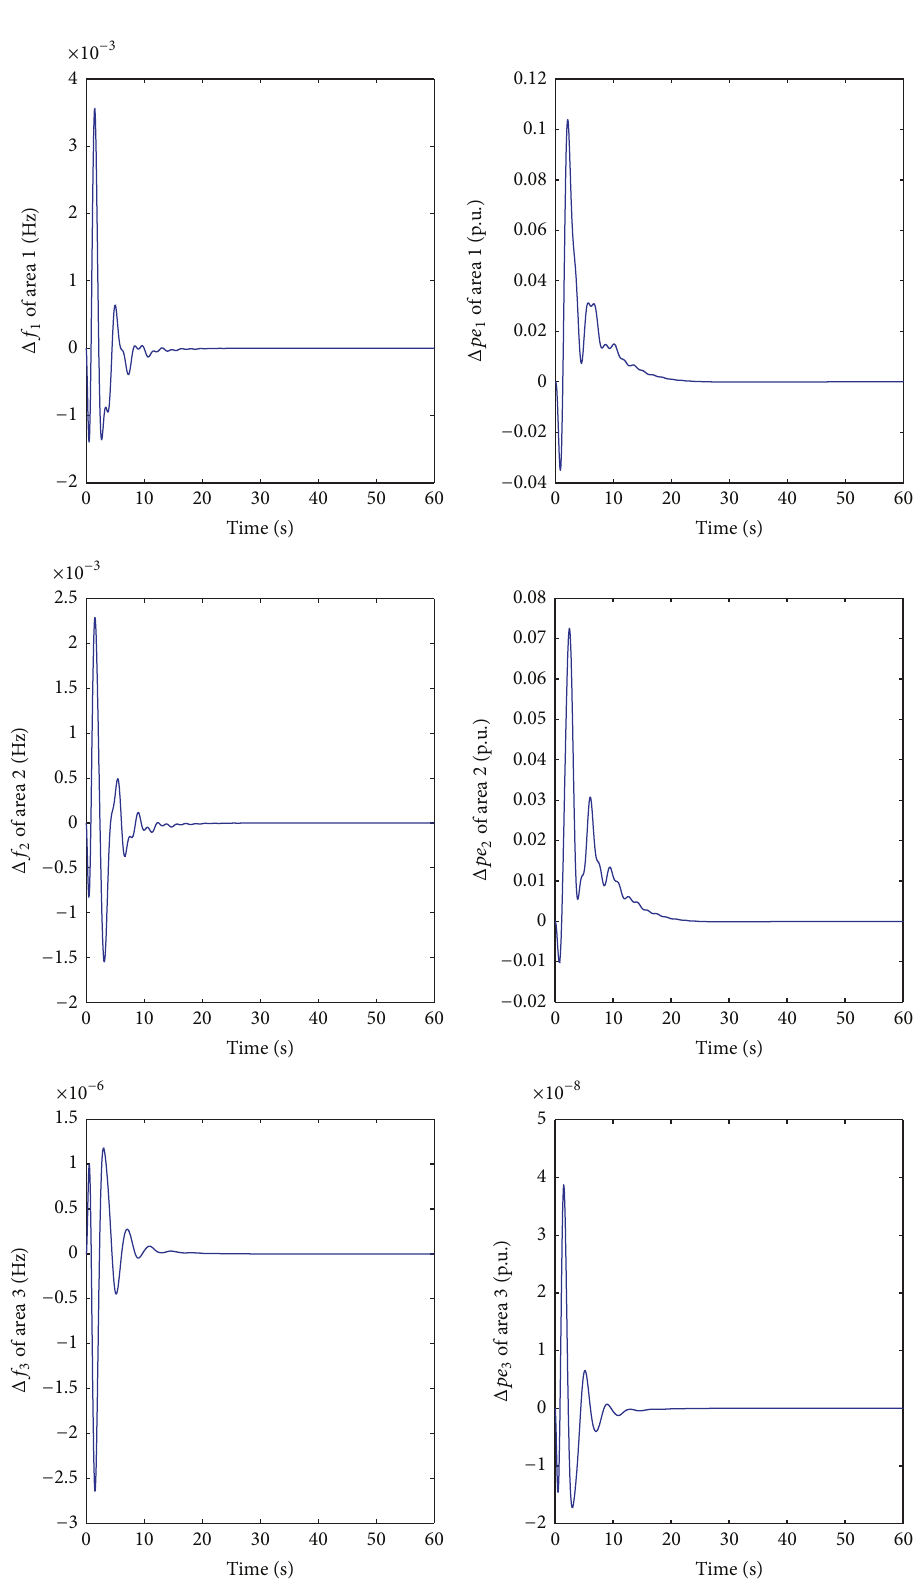
Figure 10: Step responses of the expanded system when 𝐸 1,3 varies from 1 to